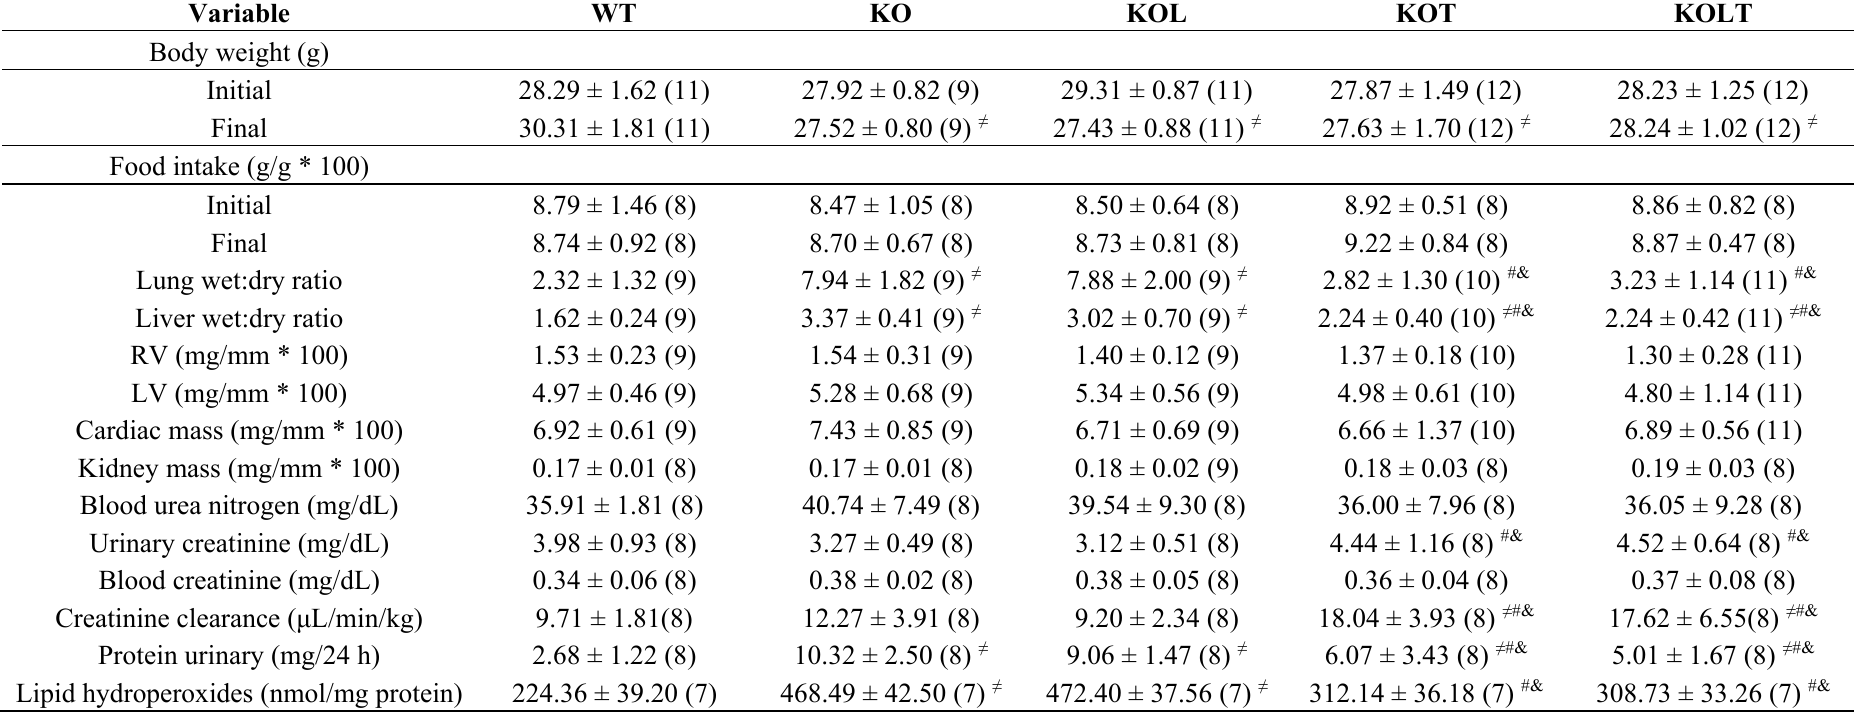
Table 1. Body weight, food intake, lung and liver wet:dry ratio, cardiac chambers and cardiac mass, kidney mass, blood urea nitrogen, urinary creatinine, blood creatinine, creatinine clearance, protein urinary and lipid hydroperoxides in wild type (WT), α 2A / α 2C ARKO mice placebo (KO) or leucine (KOL), and exercise trained (KOT) or exercise trained and leucine-supplemented (KOLT). Data are presented as mean ± SD. The number of animals studied in each group is shown within parentheses. LV: Left ventricular; RV: Right ventricular. ≠ p < 0.05 vs. WT; # p < 0.05 vs. KO; & p < 0.05 vs.